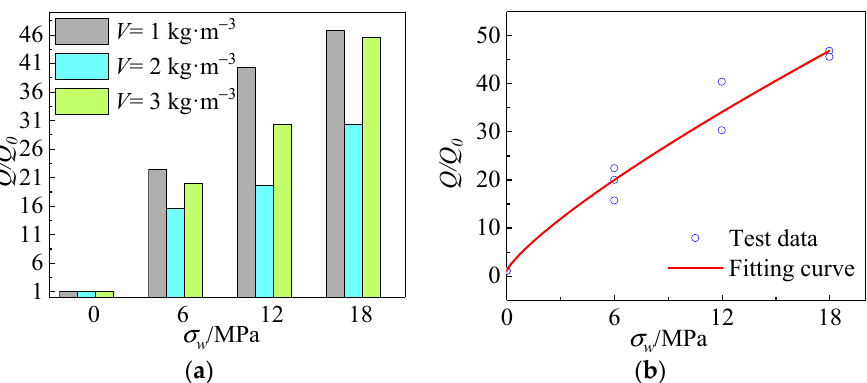
Figure 28. ( a ) Relationship between actual energy consumption and confining pressure value and fiber content; ( b ) fitting curve between actual energy consumption and confining pressure value.